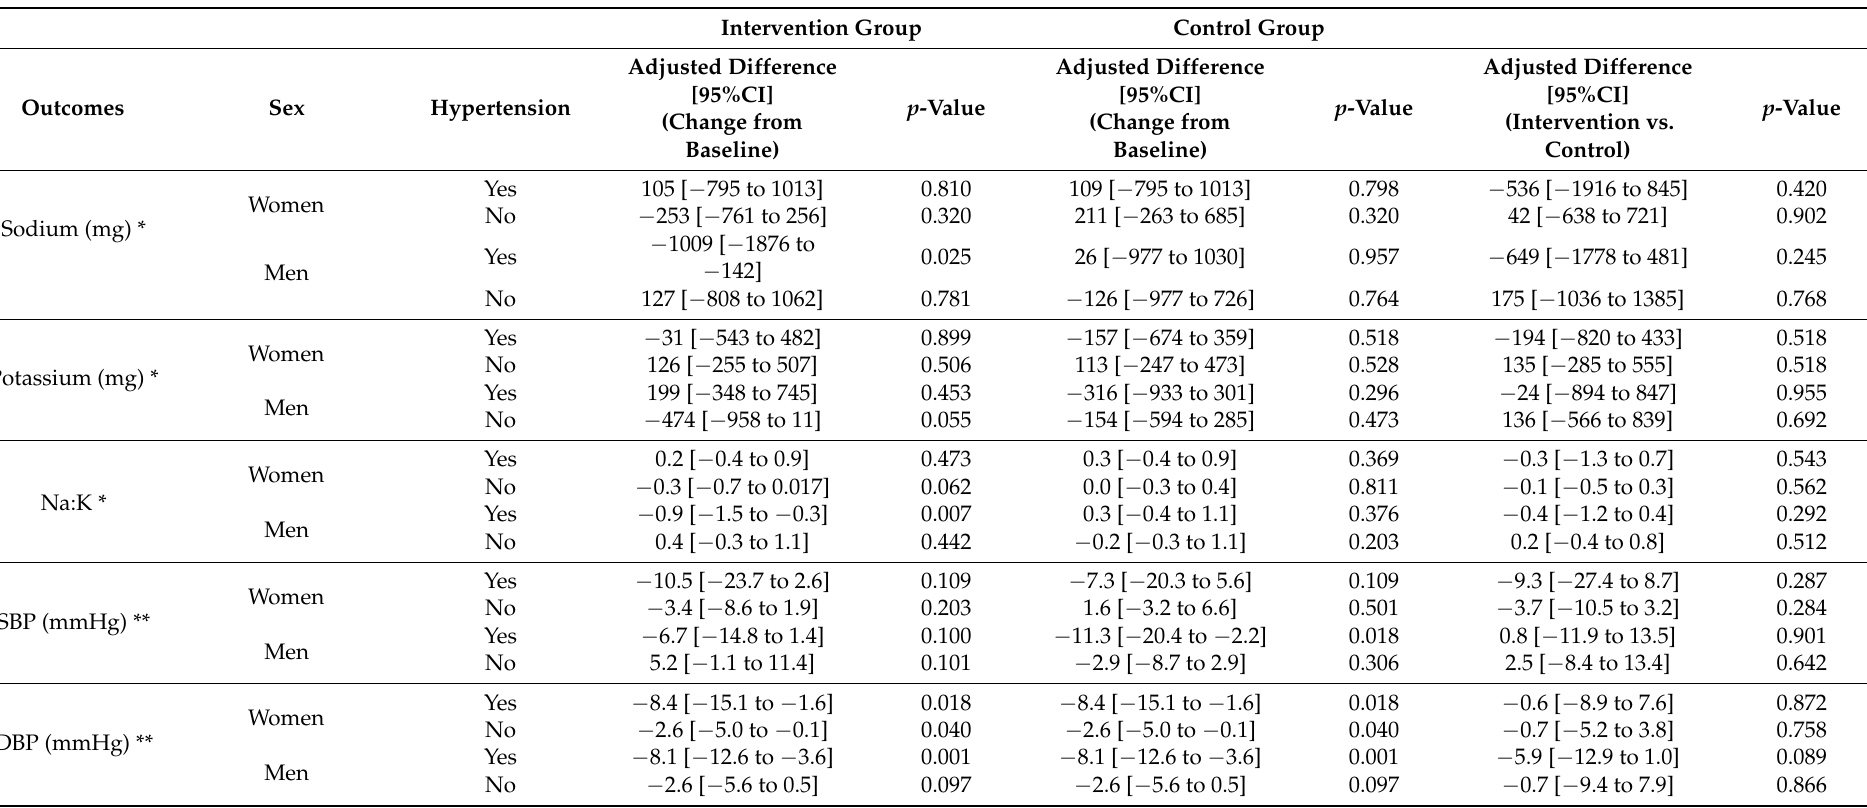
Table 4. Adjusted mean difference in sodium and potassium excretion, Na:K ratio, and blood pressure from baseline to end of intervention and mean intervention effect (adjusted mean difference (intervention vs. control)) in intention to treat by sex and by hypertension